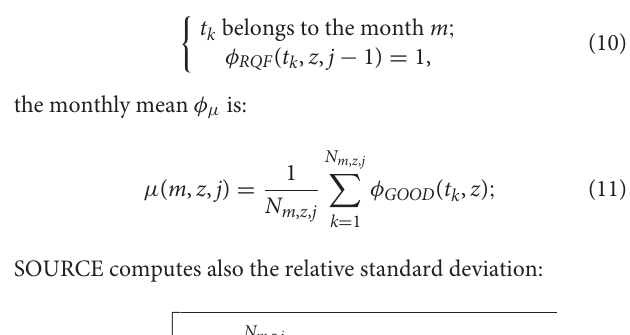
Frontiers in Marine Science |